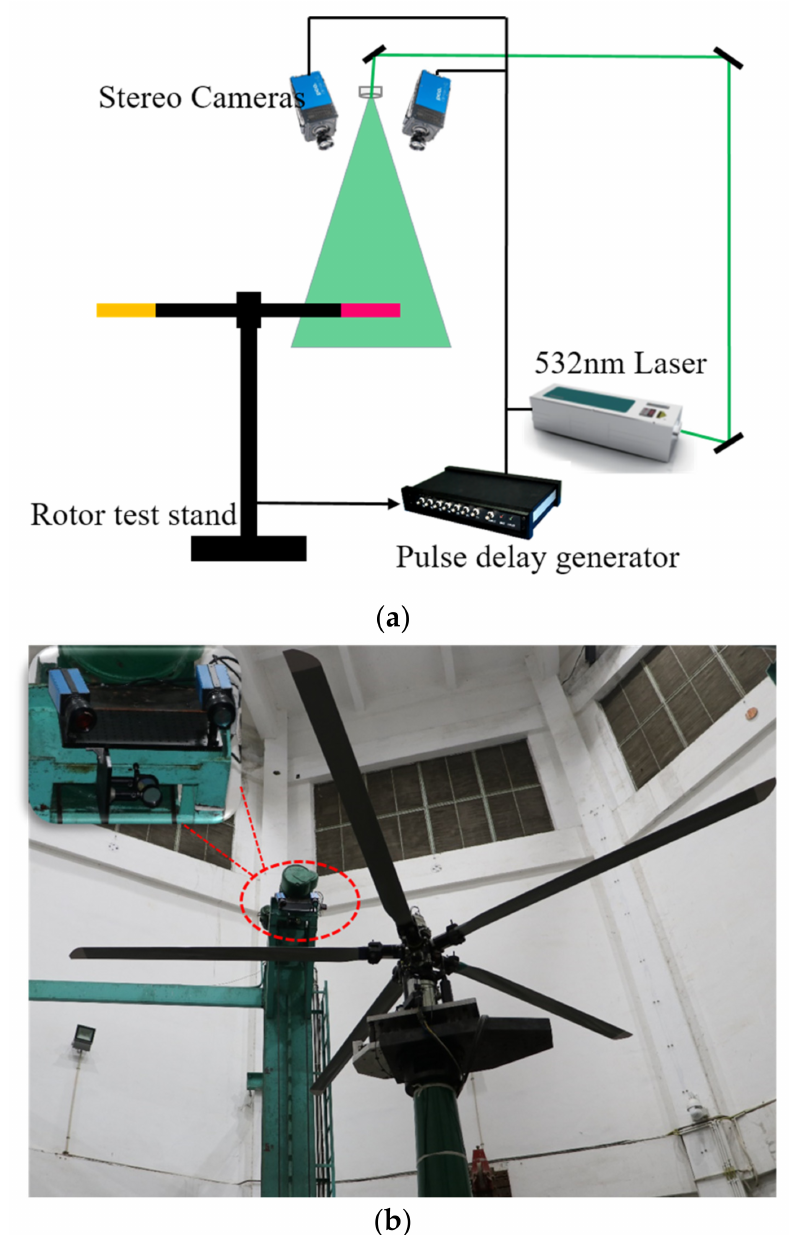
Figure 3. Experimental setup: ( a ) schematics, ( b ) image of the experimental